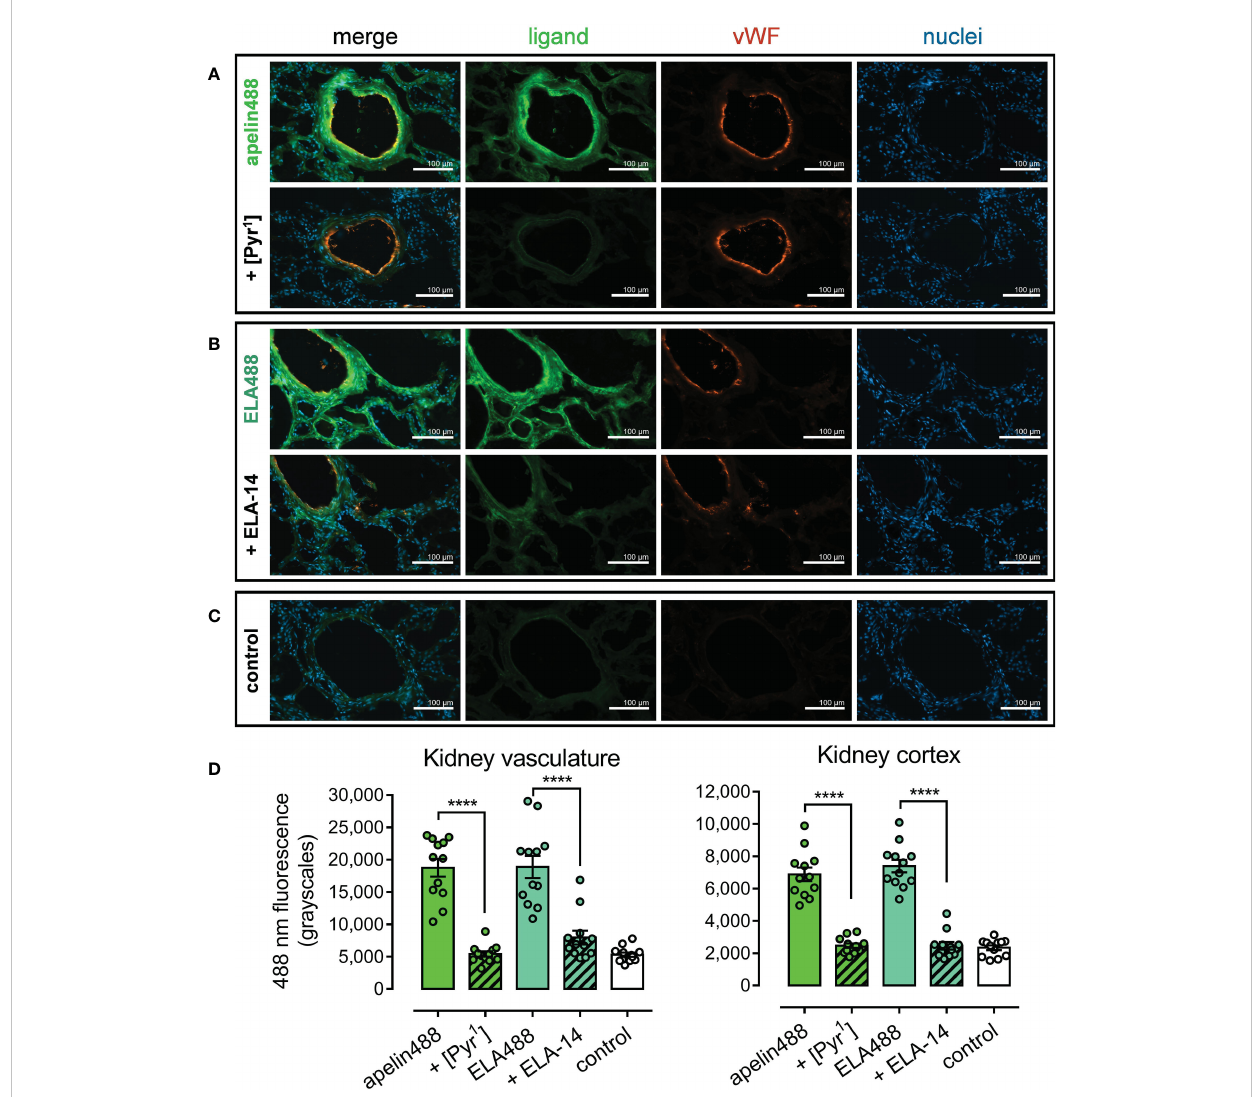
FIGURE 6 Representative fl uorescent images show speci fi c binding of apelin488 and ELA488 to vasculature and cortical tubules in human kidney. (A) Kidney sections treated with 1 µM apelin488 (visualised in green), von Willebrand factor (vWF, visualised in orange), and Hoechst 33342 nuclear stain (visualised in blue), in the absence (upper row) or presence (bottom row) of a saturating 10 µM concentration of unlabelled [Pyr 1 ]apelin-13. (B) Kidney sections treated with 1 µM ELA488 (visualised in green), von Willebrand factor (vWF, visualised in orange), and Hoechst 33342 nuclear stain (visualised in blue), in the absence (upper row) or presence (bottom row) of a saturating 10 µM concentration of unlabelled ELA-14. (C) Control panels show kidney sections treated with HBSS buffer and Hoechst 33342 nuclear stain alone (i.e. demonstrate background auto- fl uorescence levels). Scale bars show 100 µm in all images. Images representative of tissue from 3 independent donors. (D) Bar charts show quantitative 488 nm fl uorescence (grayscales) for kidney vasculature structures (left) or tubules in the cortex (right) treated with: 300 nM apelin488 alone or in the presence of 10 µM unlabelled [Pyr 1 ]apelin-13; 1 µM ELA488 alone or in the presence of 10 µM unlabelled ELA-14; or with HBSS buffer (control). Data are expressed as mean ± s.e.m., n = 12 individual data points pooled from 3 independent donors. Statistical signi fi cance was determined using a one-way ANOVA, with Tukey ’ s correction for multiple comparisons looking for differences between treatment groups. ****p <